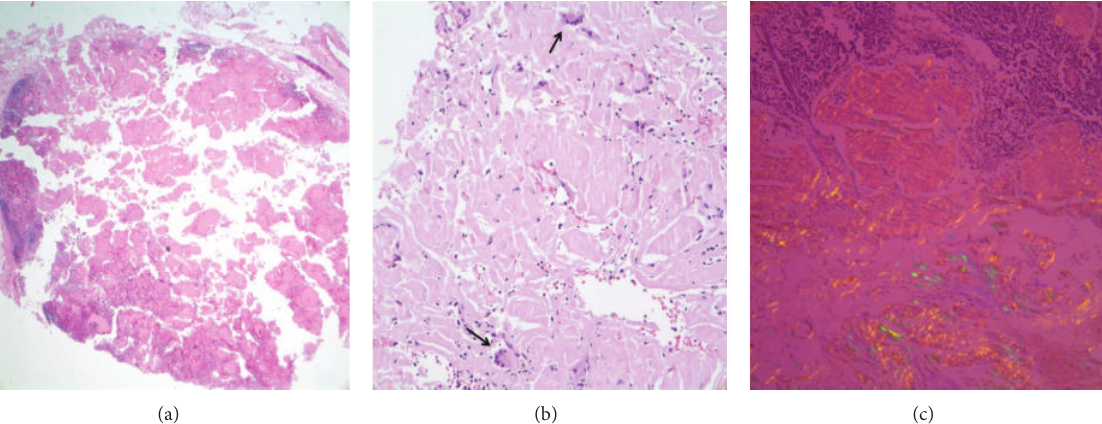
Figure 1: (a) Lymph node replaced by amorphous, eosinophilic, extracellular material (amyloid), (b) high power magnification of the amyloid with few admixed multinucleated giant cells (arrowed), and (c) Congo red stain demonstrating apple green birefringence, diagnostic of